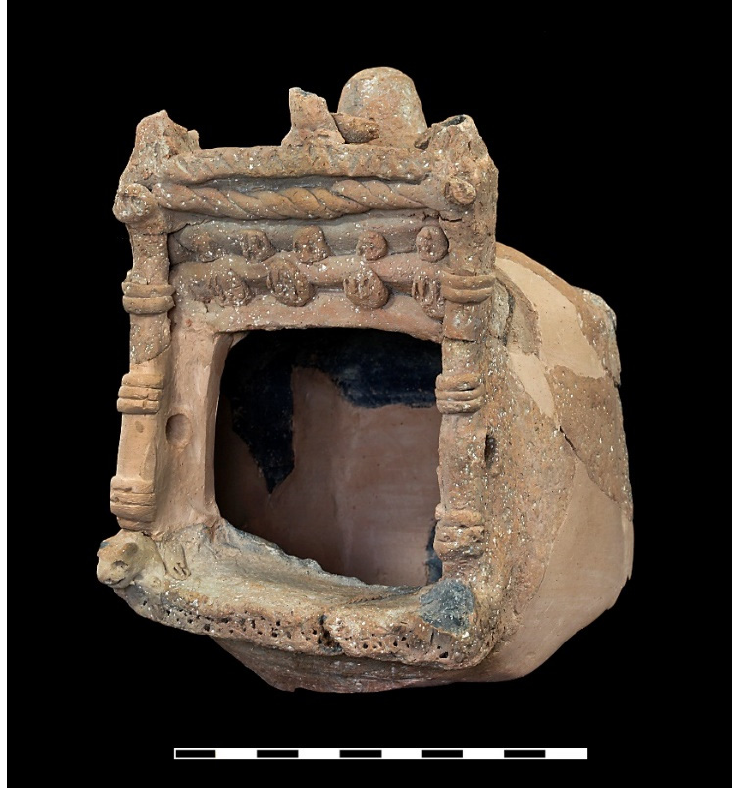
Figure 7. Clay portable shrine from Khirbet Qeiyafa, Israel, early 10th century BCE (photograph by G. Laron). Religions 2019 , 10 , x FOR PEER REVIEW